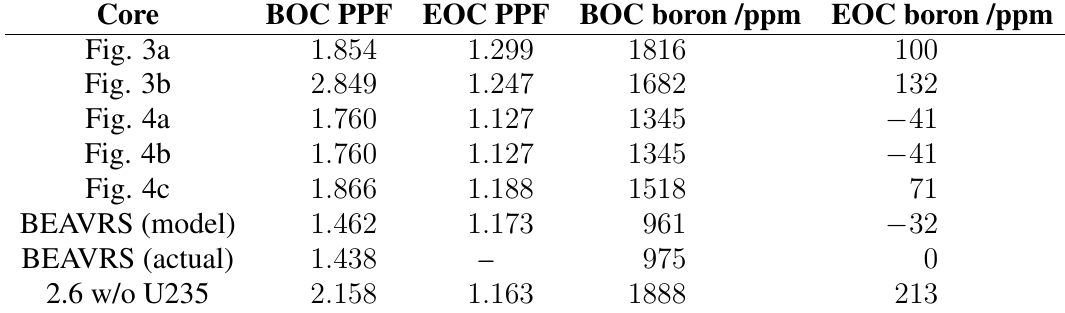
Table 2: Results for LPs burned up to 13593 MWd/tonne in